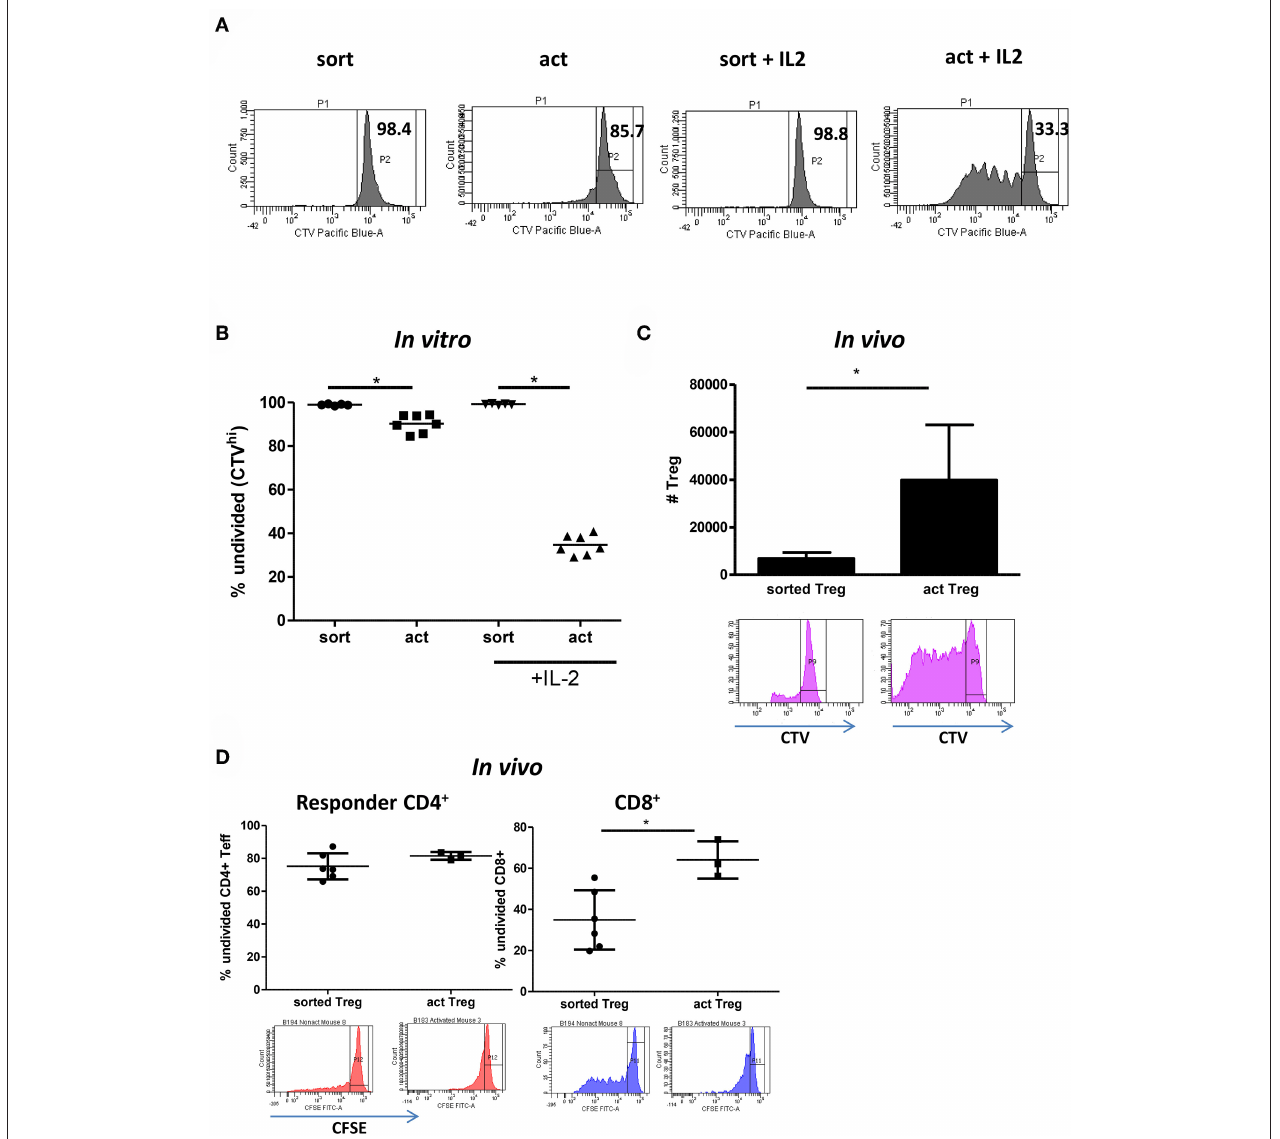
FIGURE 5 | Transient activation is sufficient to induce Treg proliferation if IL-2 is present. (A) Representative histograms and (B) graph depicting the percentage of undivided (CTV hi ) Tregs is shown. (C) 5 × 10 6 CFSE-labeled PBMC and 1 × 10 6 CTV-labeled freshly isolated Tregs ( n = 6) or transiently activated Tregs ( n = 3) were injected intraperitoneally into immunodeficient BRG mice. The number of CTV + cells in the peritoneum on day 5 is depicted on the graph. Histograms represent CTV dilution in gated Tregs from freshly isolated and transiently activated Treg groups respectively. (D) Cells were prepared and injected as in (C) . The percentage of undivided (CFSE hi ) responder CD4 + and CD8 + lymphocytes is shown. CFSE dilution in gated responder CD4 + and CD8 + T cells in mice receiving freshly isolated and transiently activated Tregs is shown. (C) mean with SD is depicted, (D) each point represents separate mouse. Groups were compared using a non-parametric Mann-Whitney U -test. * p <